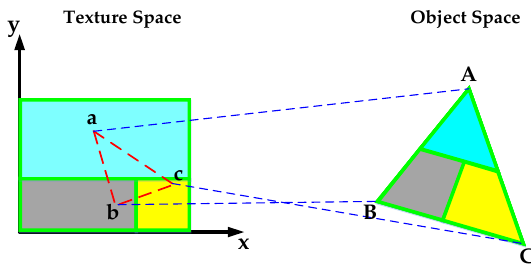
Figure 22. Correspondence between object space and texture space.